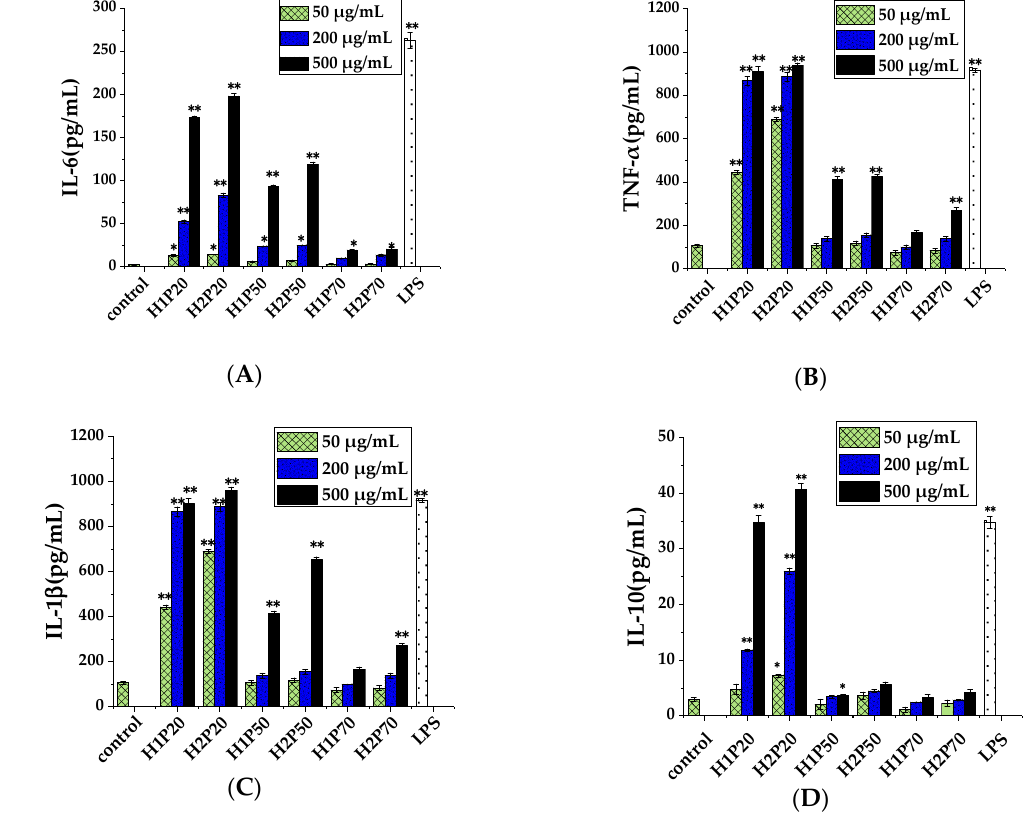
Figure 6. Effect of 20% (50%, 70%) ethanol precipitated polysaccharides on IL-6 ( A ), TNF- α ( B ), IL-1 β ( C ), and IL-10 ( D ) from THP-1 cells. H1P20 (H1P50, H1P70): 20% (50%, 70%) ethanol precipitated polysaccharides from the original H. erinaceus ; H2P20 (H2P50, H2P70): 20% (50%, 70%) ethanol precipitated polysaccharides from the ARTP mutagenic H. erinaceus . Each value represents the mean ± SD. * p < 0.05, ** p < 0.01 compared to the negative control (PBS treatment).